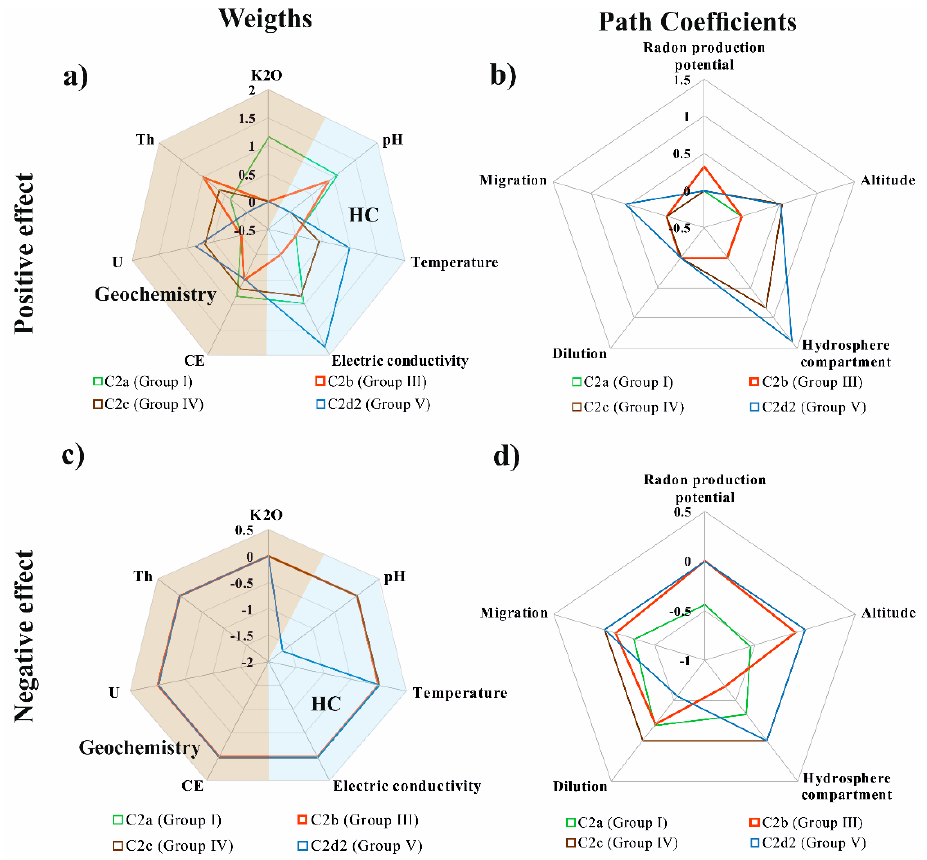
Figure 11. Summary of all PLS-PM models for weights and path coefficients results with positive and negative effects: ( a ) positive effects of weights; ( b ) positive effect of Path coefficients; ( c ) negative effects of weights and ( d ) negative effects of path coefficients. Please, see additional information in Section 5.